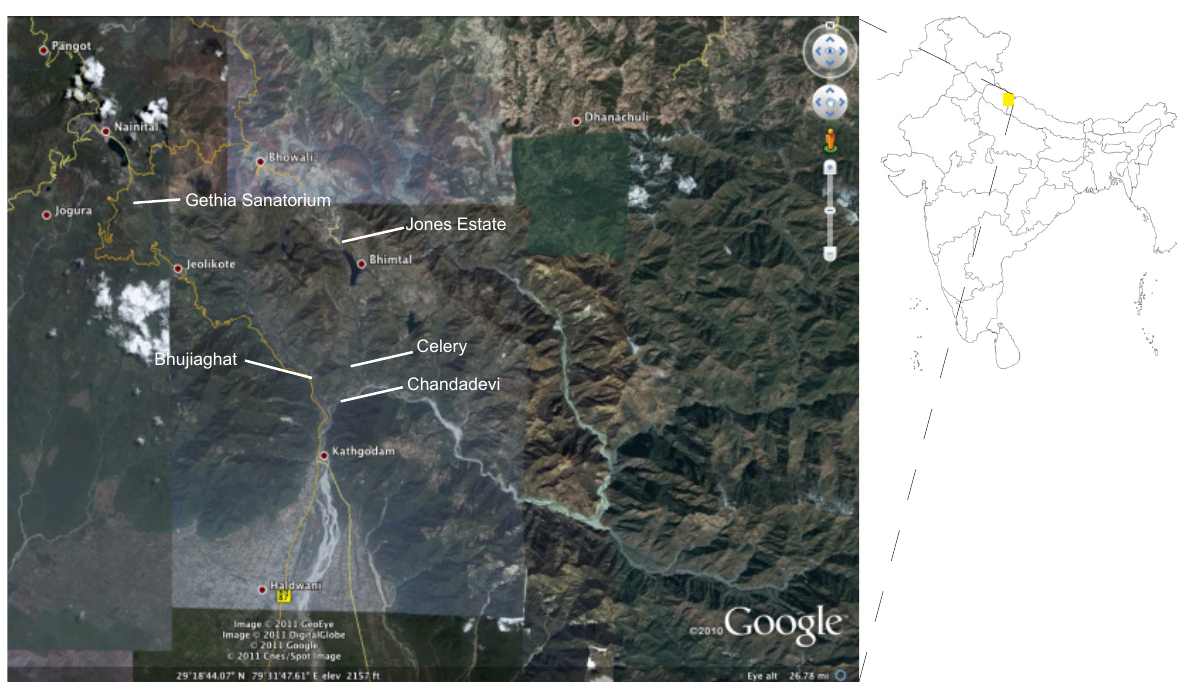
Image 2. Areas of collection of